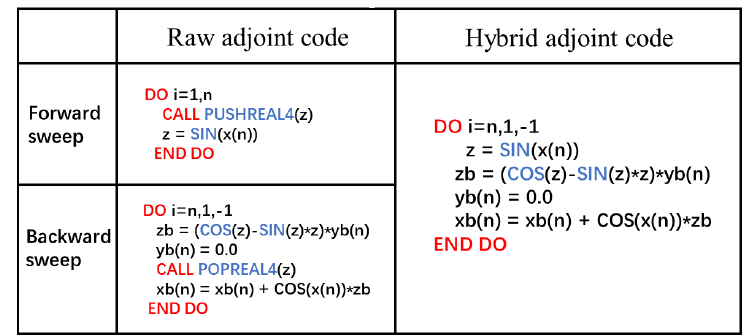
Figure 4. Case 2: the raw adjoint code and the hybrid adjoint